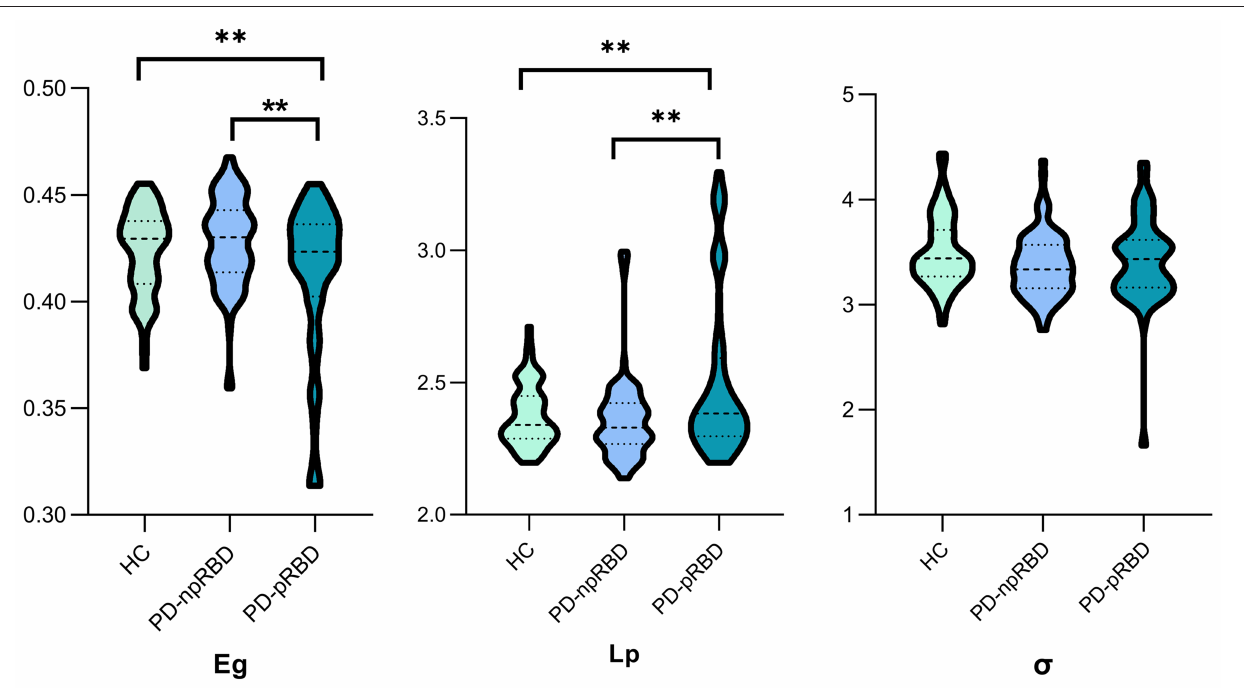
FIGURE 1 | One-way ANCOVA of global parameters among the three groups. Significant differences of global parameters of the structural network were detected among the three groups, performed by one-way ANCOVA, adjusting for age, gender and education years. p < 0.05 was set significant. Afterwards, two-sample t-test was employed to explore further differences. **Post hoc tests were corrected by Bonferroni correction with a significant different p < 0.017 (0.05/3). Eg., global efficiency; Lp, shortest path length; σ , small-world index.